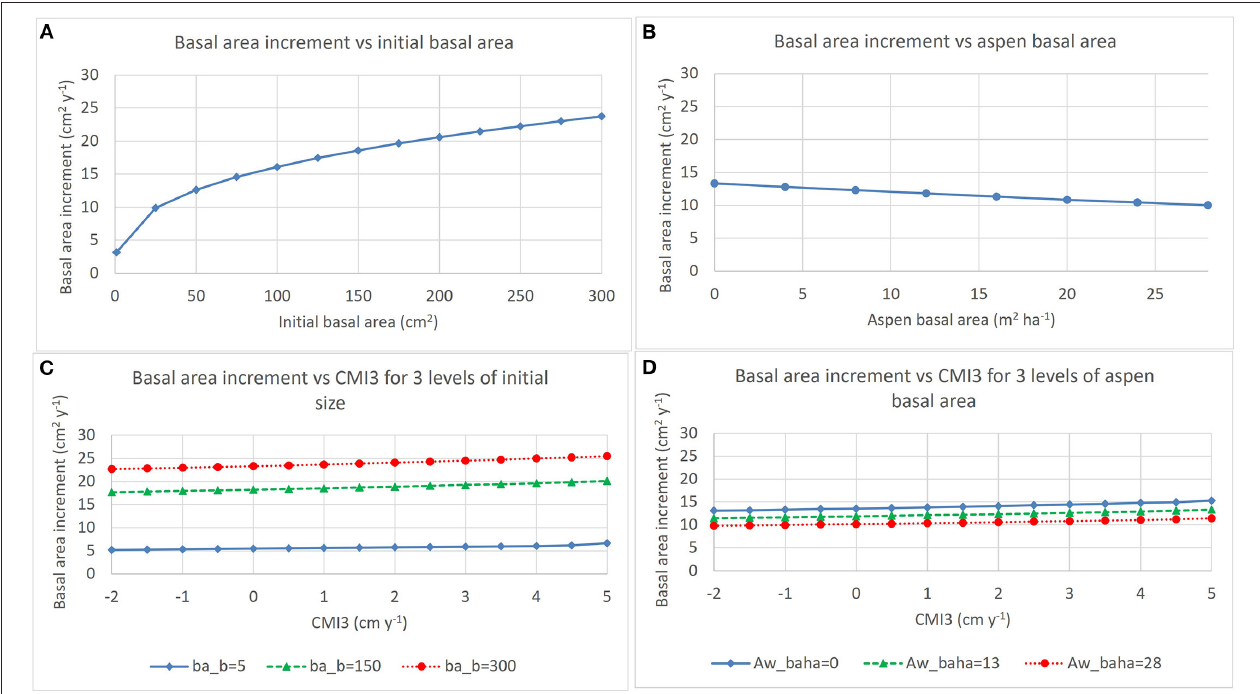
FIGURE 5 | Trends described by the model for annual basal area increment of spruce described in Table 4 . Effects of initial basal area and aspen basal area on basal area increment are shown in (A,B) , respectively. (C) Shows effects of interactions between CMI3 and initial basal area (ba_b) and (D) shows interaction between CMI3 and aspen basal area (Aw_baha) (for each panel, average values were used for all other variables in the